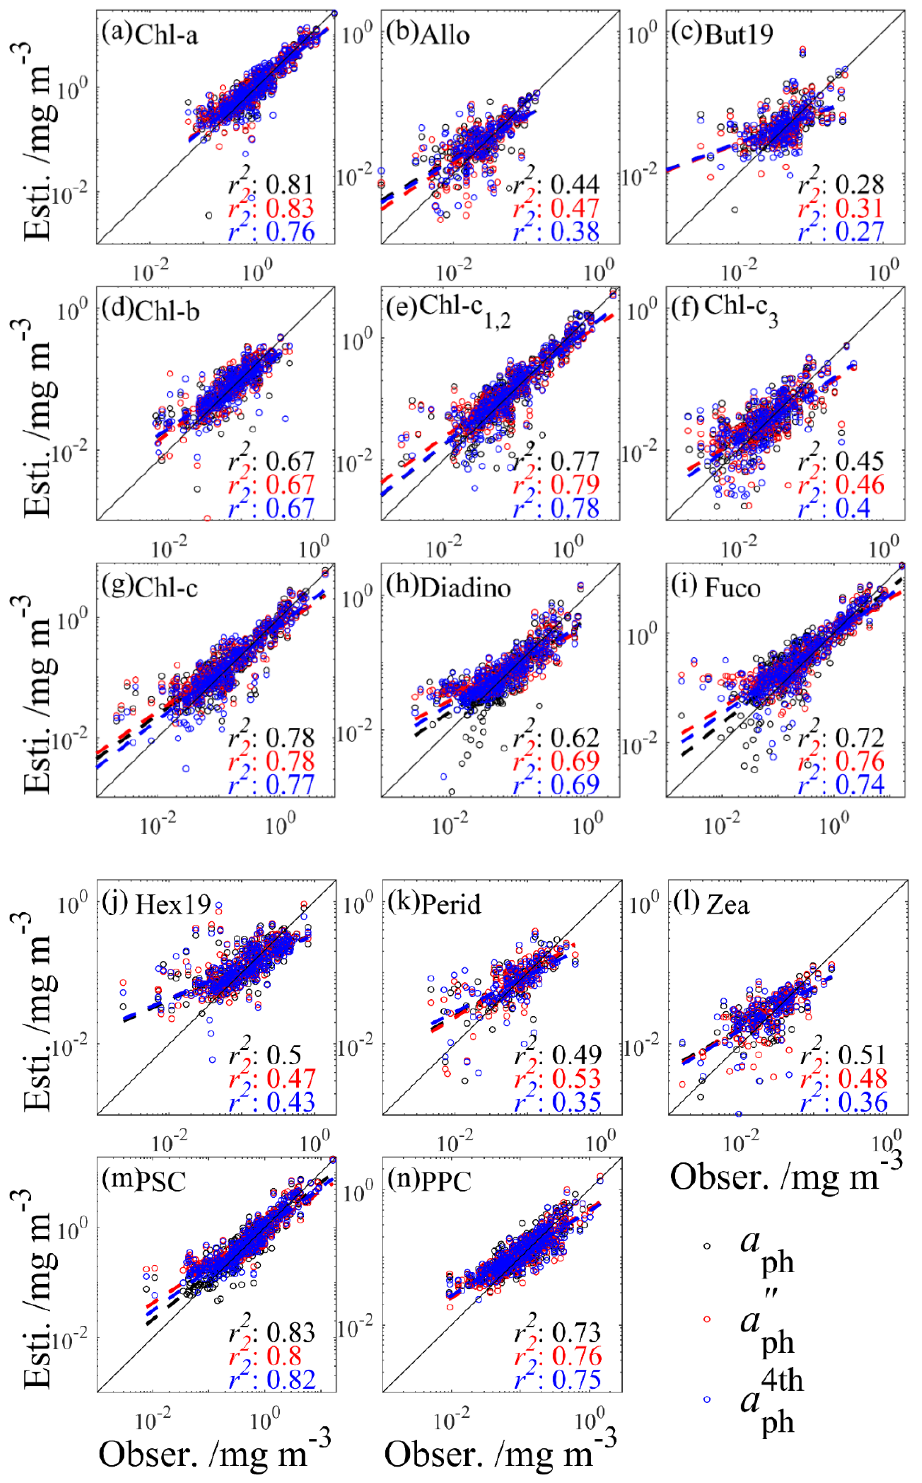
Figure 6. Comparison of inversion performances derived by the PLS model of 14 phytoplankton pigments ( a – n ) using 𝑎 (cid:2886) (𝜆) (black), 𝑎 (cid:2886)(cid:4593)(cid:4593) (𝜆) (red), and 𝑎 (cid:2886)(cid:2872)(cid:2930)(cid:2918) (𝜆) (blue) as input. The best-fit line shows a first-order linear regression performed on the log-transformed data. The black line represents the 1:1 line. Results were obtained using the testing set together with the model tuned using the training set.